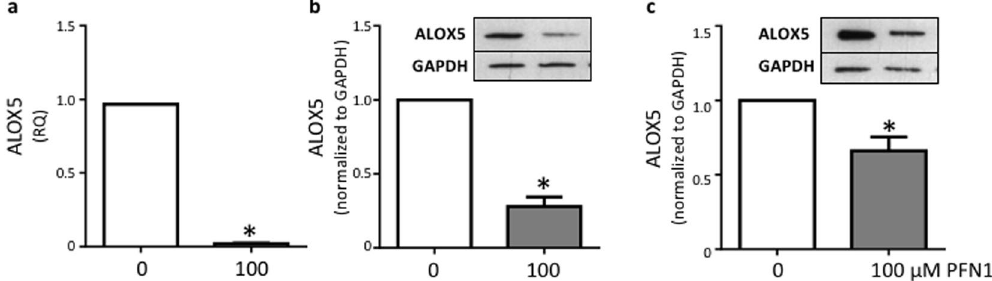
Figure 5. Exogenous profilin 1 decreased THP-1 ALOX5 expression. ( a ) ALOX5 mRNA was decreased after 24 hr treatment with PFN1 (100 μ M) in THP-1 cells (n = 4). ALOX5 protein was decreased after ( b ) 48 h (n = 3) and ( c ) 72 hr (n = 3) of PFN1 (100 µ M) treatment on THP-1 cells determined by Western blot normalized to GAPDH. mRNA expression was determined by semi-quantitative PCR normalized to 18S. Data are mean ± SEM, * p < 0.05, significant difference from control. a-c: student’s t-test.